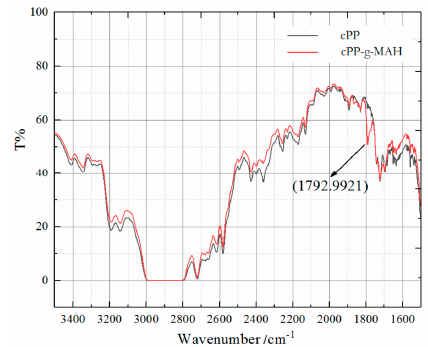
Figure 1. Fourier-transform infrared (FTIR) spectra of copolymerized polypropylene (cPP) and cPP grafted by maleic anhydride (cPP- g -MAH).